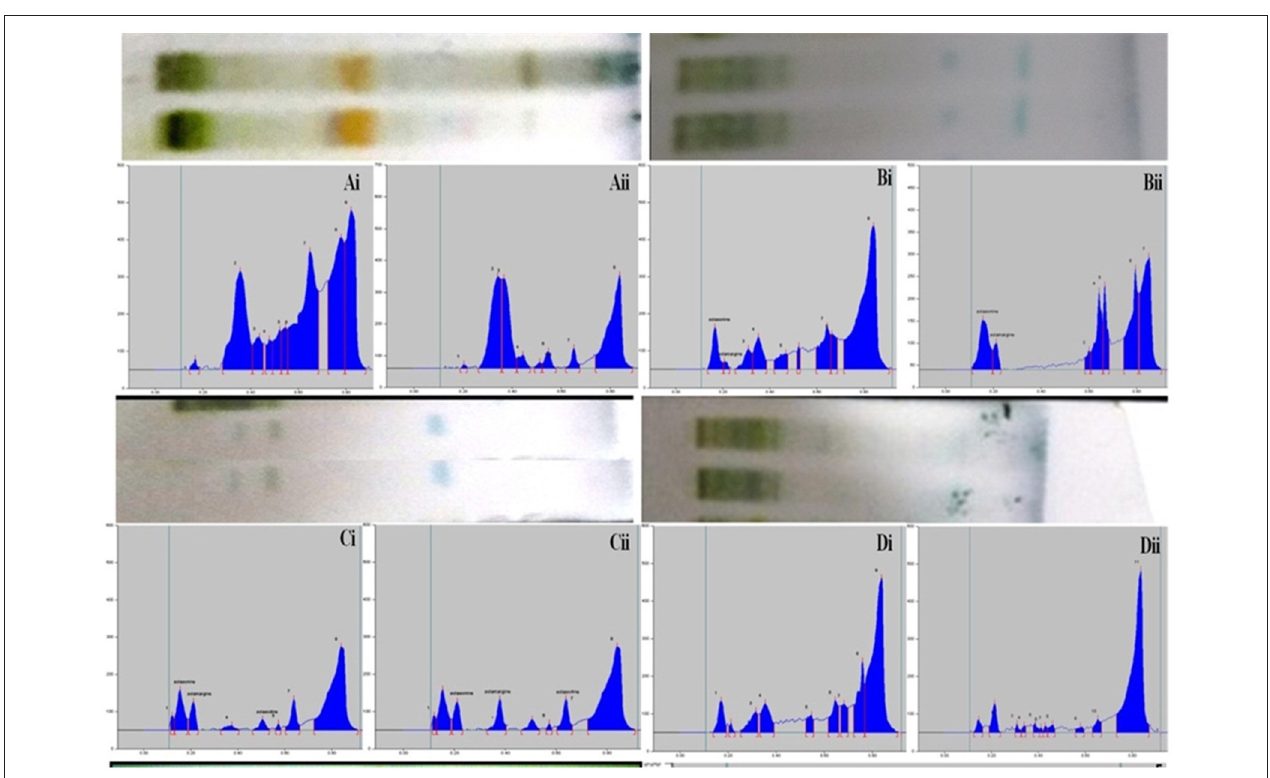
FIGURE 2 | Developed TLC plates and HPTLC chromatograms of different fractions showing peaks of separated markers. Track correspond to Ai : Hexane fraction (leaves), Aii : Hexane fraction (berries), Bi : DCM fraction (leaves), Bii : DCM fraction (berries), Ci : n-butanol fraction (leaves), Cii : n-butanol fraction (berries), Di : Final extract (leaves), Dii : Final extract (berries).